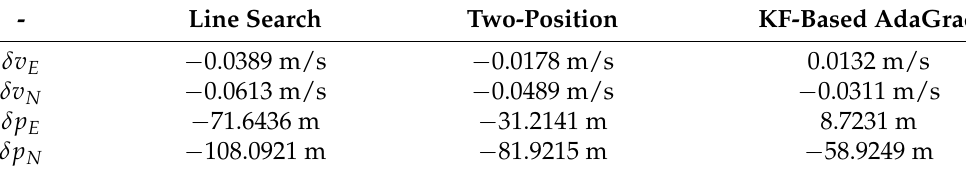
Table 6. Maximum errors of velocity and position.